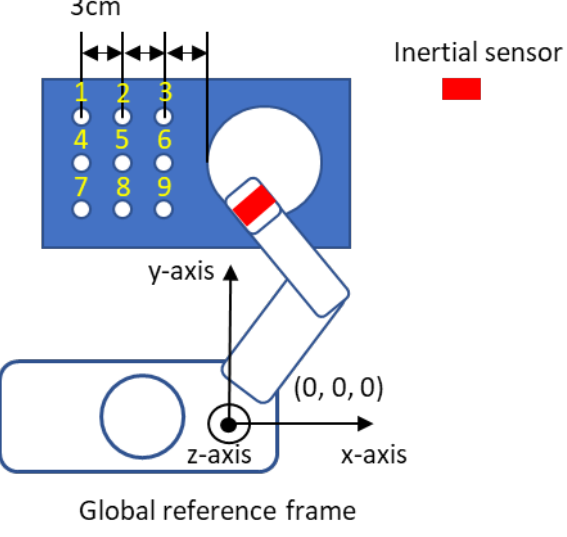
Figure 3. Illustration of NHPT.